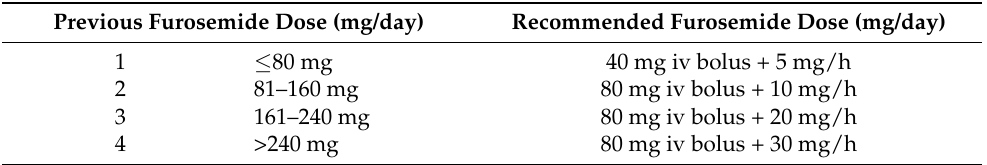
Table 1. The recommended Furosemide regimens to attain targeted fluid